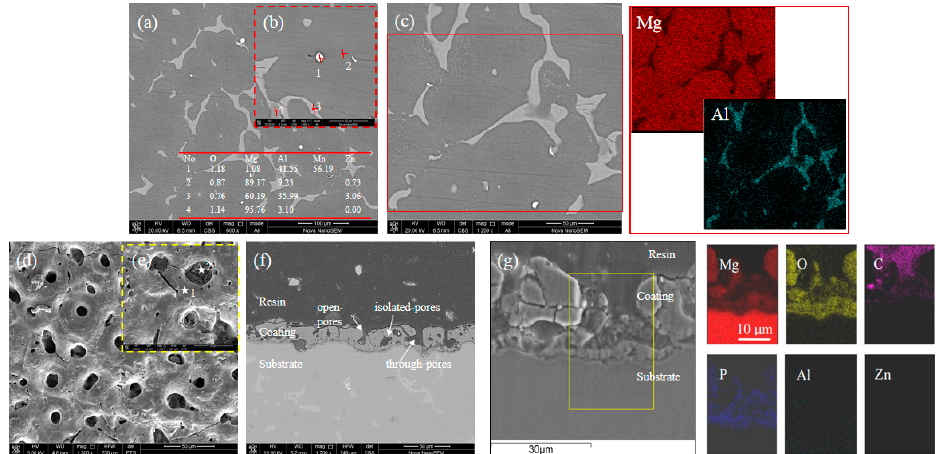
Figure 1. SEM images showing the microstructure of the AZ91 alloy before and after MAO treat- ment. ( a ) SEM image and ( b , c ) magnified SEM images for the as-received alloy; ( d , e ) Coating surface image; ( f , g ) Interface images for the coated alloy. The EDS mapping images correspond to the SEM images of ( c , g ).